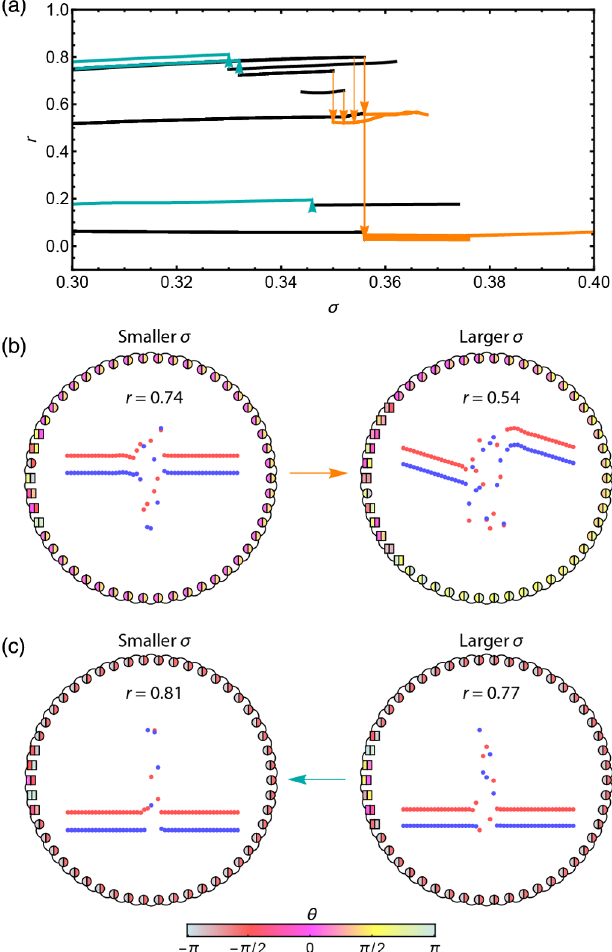
FIG. 7. Inverted transitions between solution branches under quasistatic variations in the coupling strength. (a) Inverted transitions for which an increase (or decrease) in the coupling strength results in a transition to a less (or more) synchronous solution. Example (b) forward- and (c) backward-inverted tran- sitions, as in Fig.